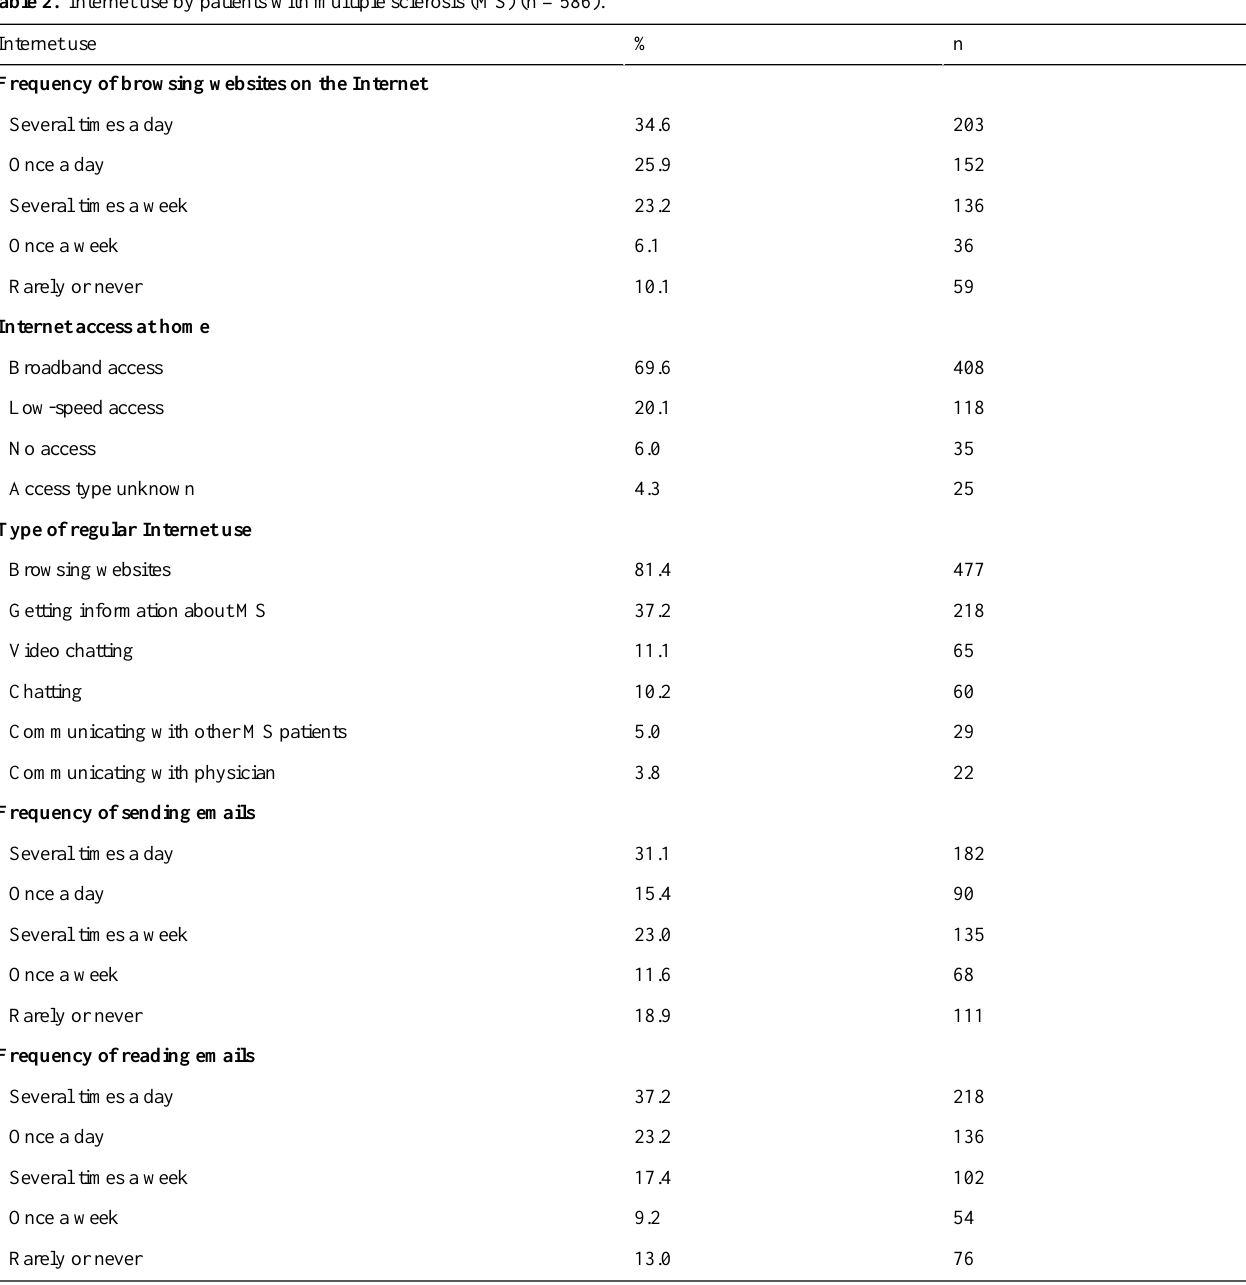
Table 2. Internet use by patients with multiple sclerosis (MS) (n =